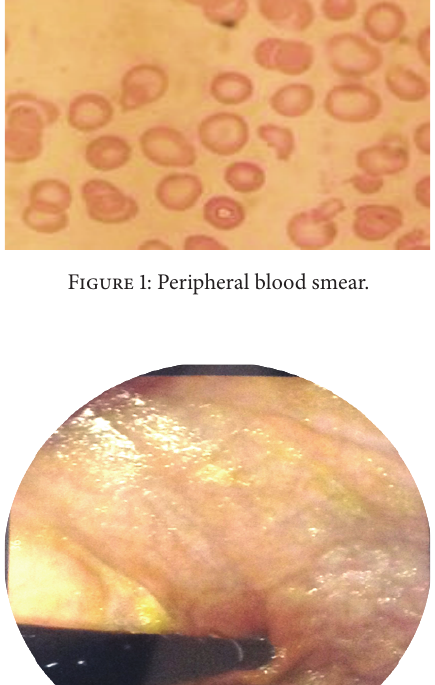
Treatment with 1000 𝜇 g of vitamin B12 in intramuscular injections on a daily basis for 10 days resulted in hematolog- ical and clinical improvement, along with a decrease in D- dimer